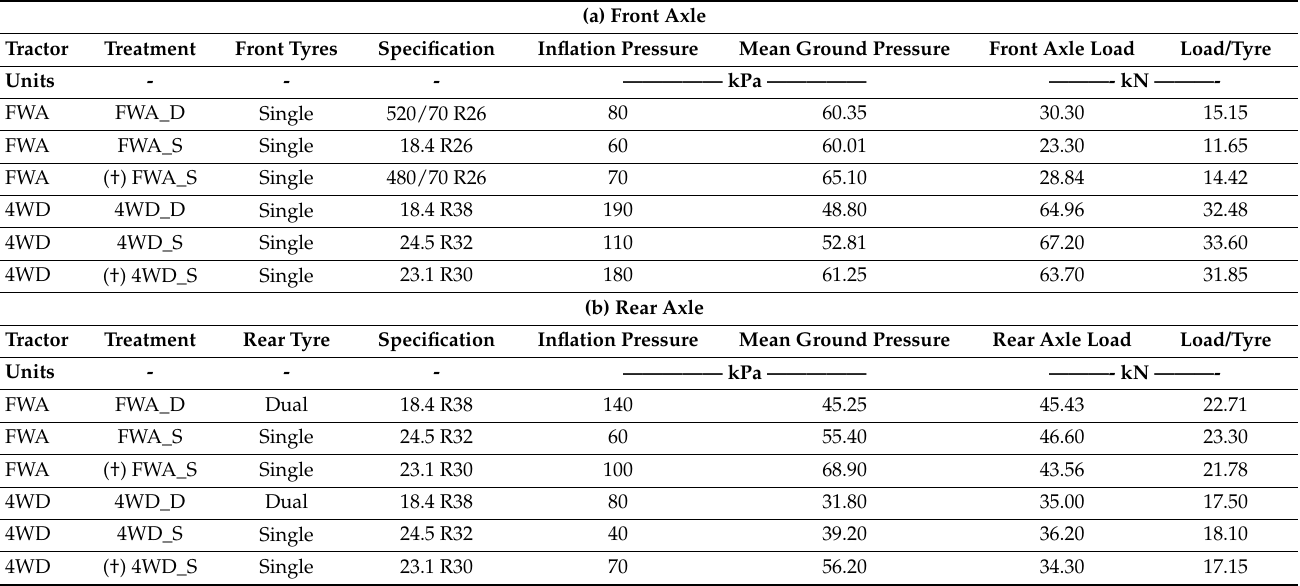
Table 2. (Top): Description of tractors, specification of front tyres and settings, and front axle loads used in the experiments. Notation: ‘FWA’ (front-wheel assist), 4WD (four-wheel drive), ‘D’ (dual tyres), and ‘S’ (single tyres). The symbol (†) denotes the tractor fitted with tyres supplied by the local dealer (or selected by customers when the equipment was first acquired), and (Bottom): Description of tractors, specification of rear tyres and settings, and rear axle loads used in the experiments. Notation: ‘FWA’ (front-wheel assist), 4WD (four-wheel drive), ‘D’ (dual tyres), and ‘S’ (single tyres). The symbol (†) denotes the tractor fitted with tyres supplied by the local dealer (or selected by customers when the equipment was first